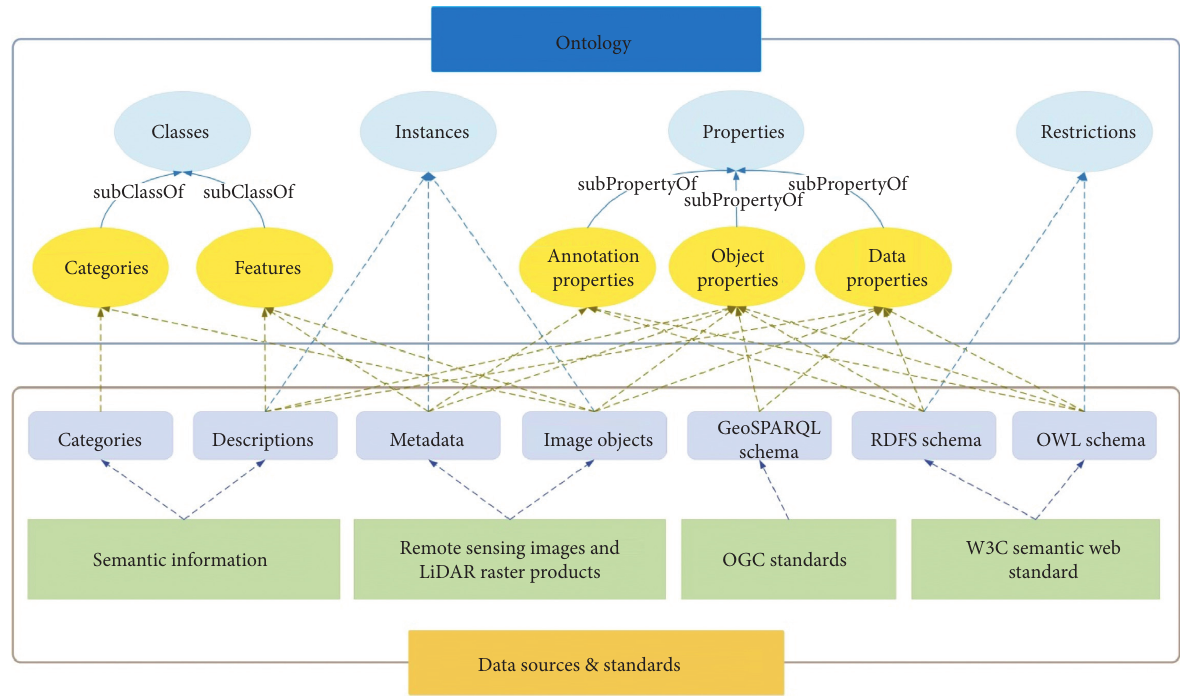
Figure 1: Conceptual model of our developed ontologies. Table 1: Low-level features and computing